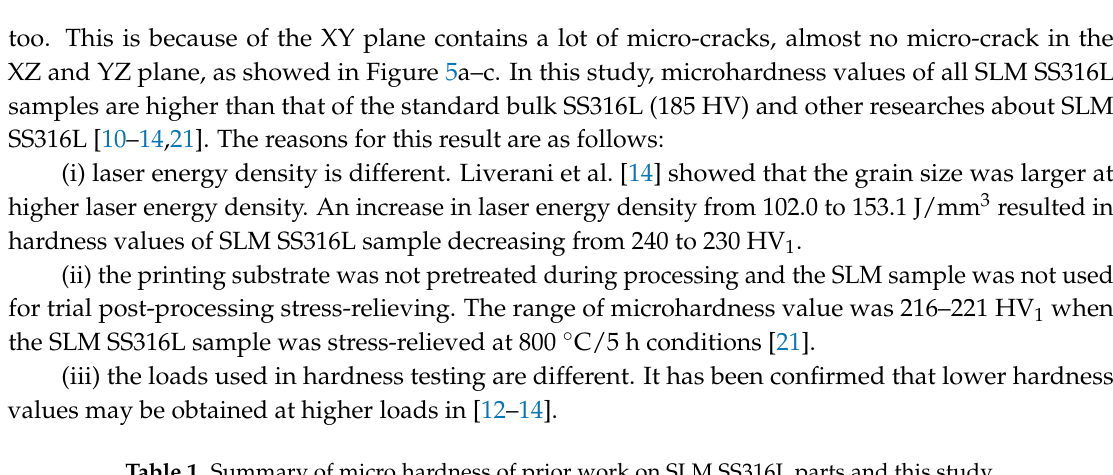
Table 1. Summary of micro hardness of prior work on SLM SS316L parts and this study. Particle Size ( µ